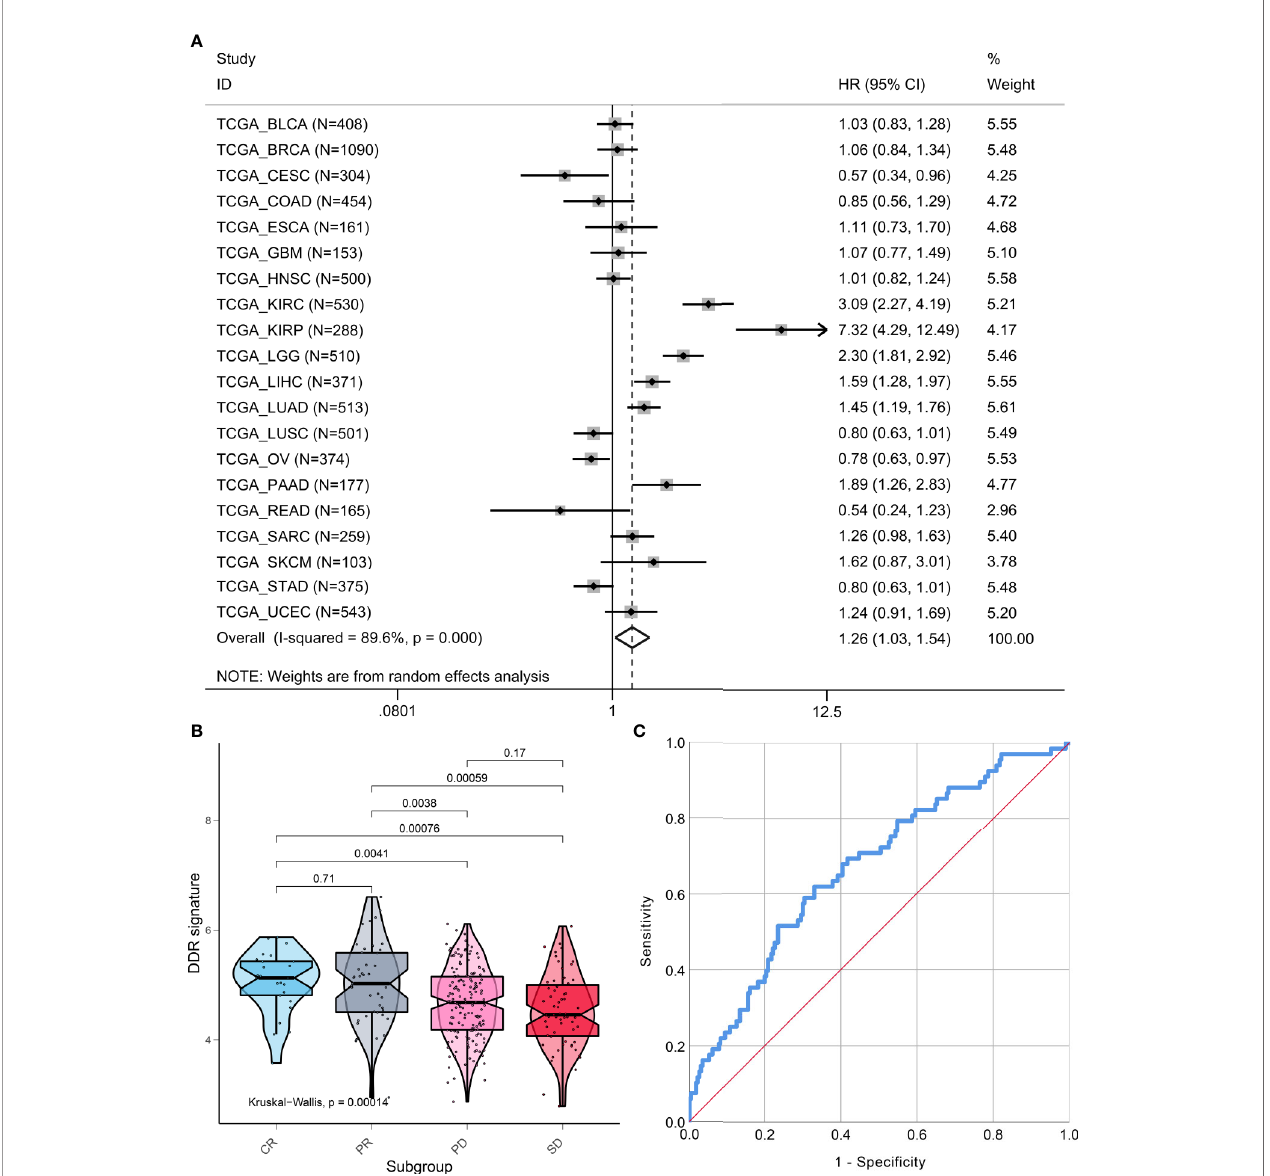
FIGURE 7 | Pan-cancer prognostic value and immunotherapy response prediction of DDR signature. (A) Pan-cancer analysis to evaluate prognostic value of DDR signature. (B) TME scores in groups with different anti-PD-L1 clinical response statuses. (C) A receiver-operating characteristic (ROC) curve was used to measure the performance of the DDR subtype signature in immunotherapy response